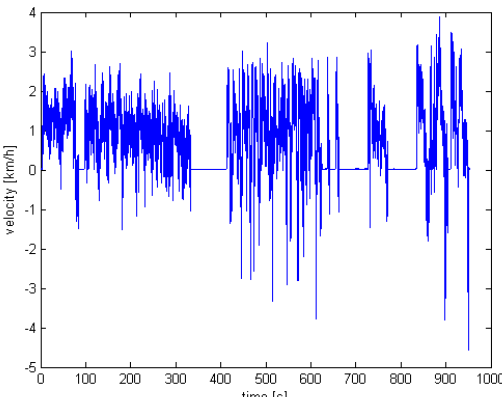
Figure 10. The velocity difference between in-vehicle sensor and reference data